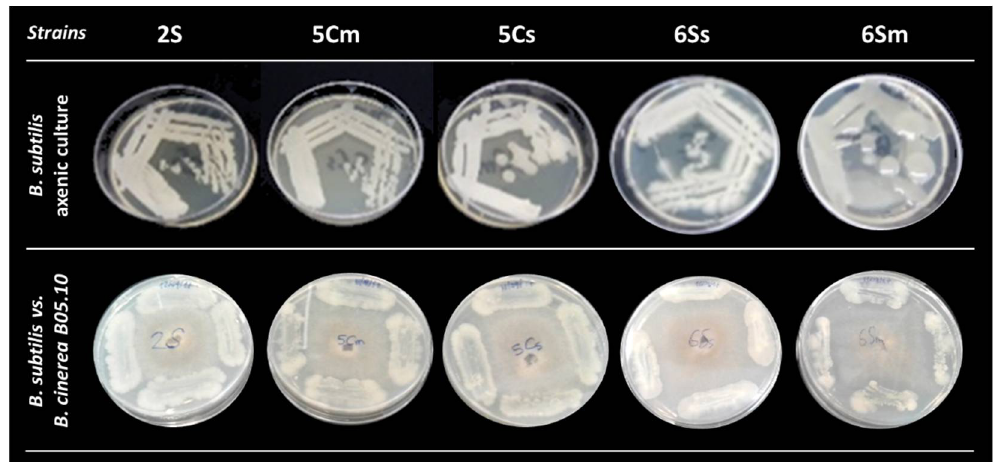
Figure 2. Bacillus subtilis strains in axenic culture (top-line); B. subtilis vs. B. cinerea during antagonistic test